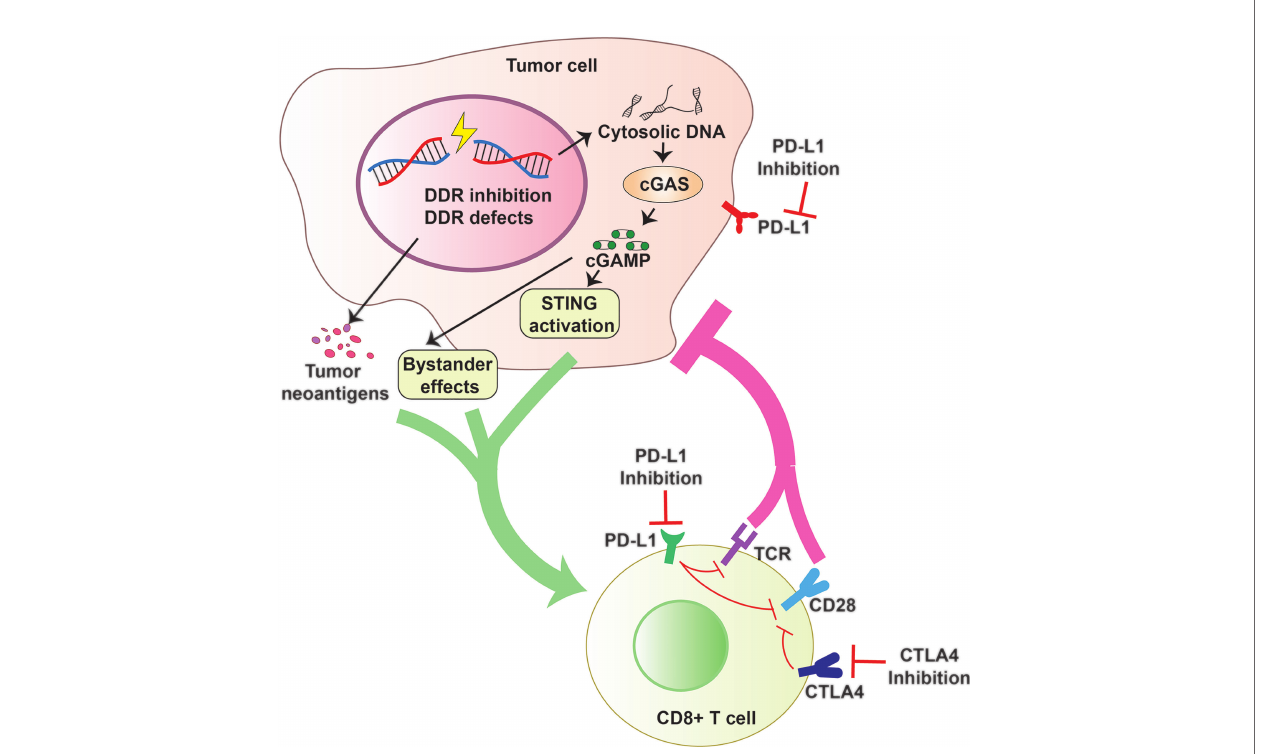
FIGURE 4 | DDR Inhibition and Antitumor Immunity. DDR Inhibition and DDR defects can increase cytosolic DNA that activates the cGAS to generate cGAMP and promote tumor neoantigen production. cGAMP can activate cell intrinsic STING pathway and spread the immunity to bystander cells. All these factors contribute to an in fl ammatory tumor microenvironment and promote the recruitment of cytotoxic CD8+ T cells and constrict cancer growth effectively. Combining DDR inhibition (such as PARP or PARG inhibition) with Immune checkpoint blockade (including PD-1/PD-L1 or CTLA4 blockade) may be a promising strategy with the potential to improve survival